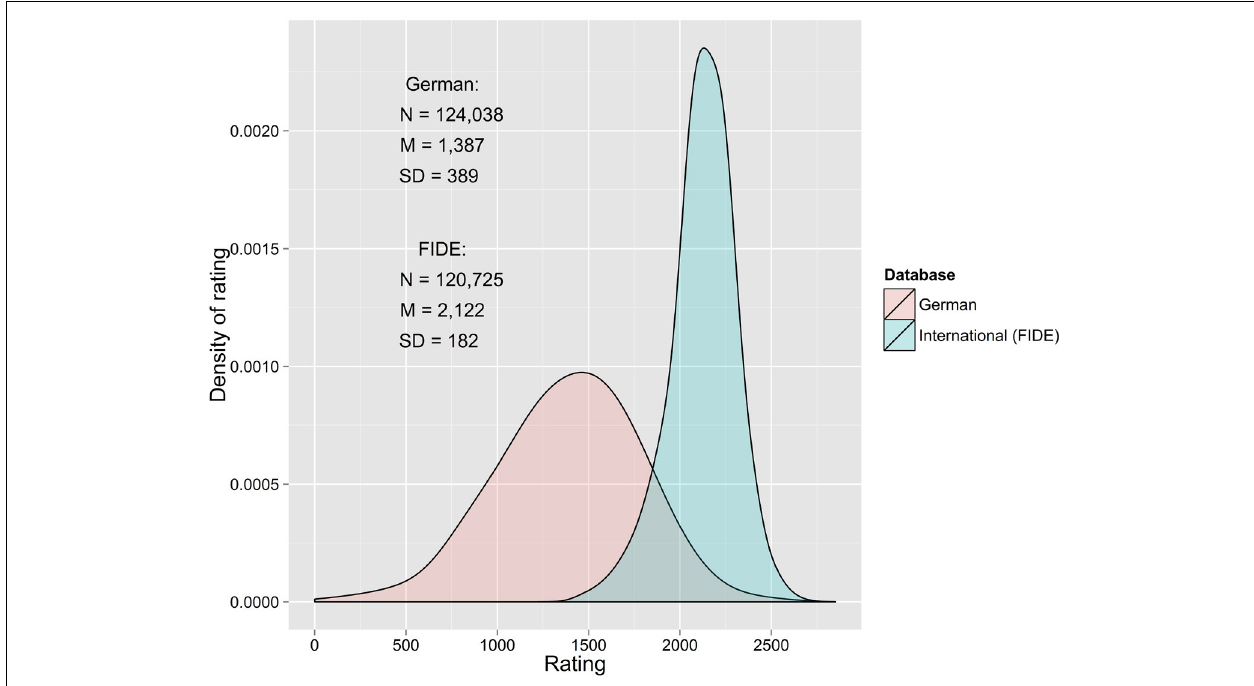
FIGURE 1 | Distribution of chess skill as measured by Elo rating in FIDE (blue color) and German (red) databases (as of 2008). The databases contain similar number of players, but differ vastly in the